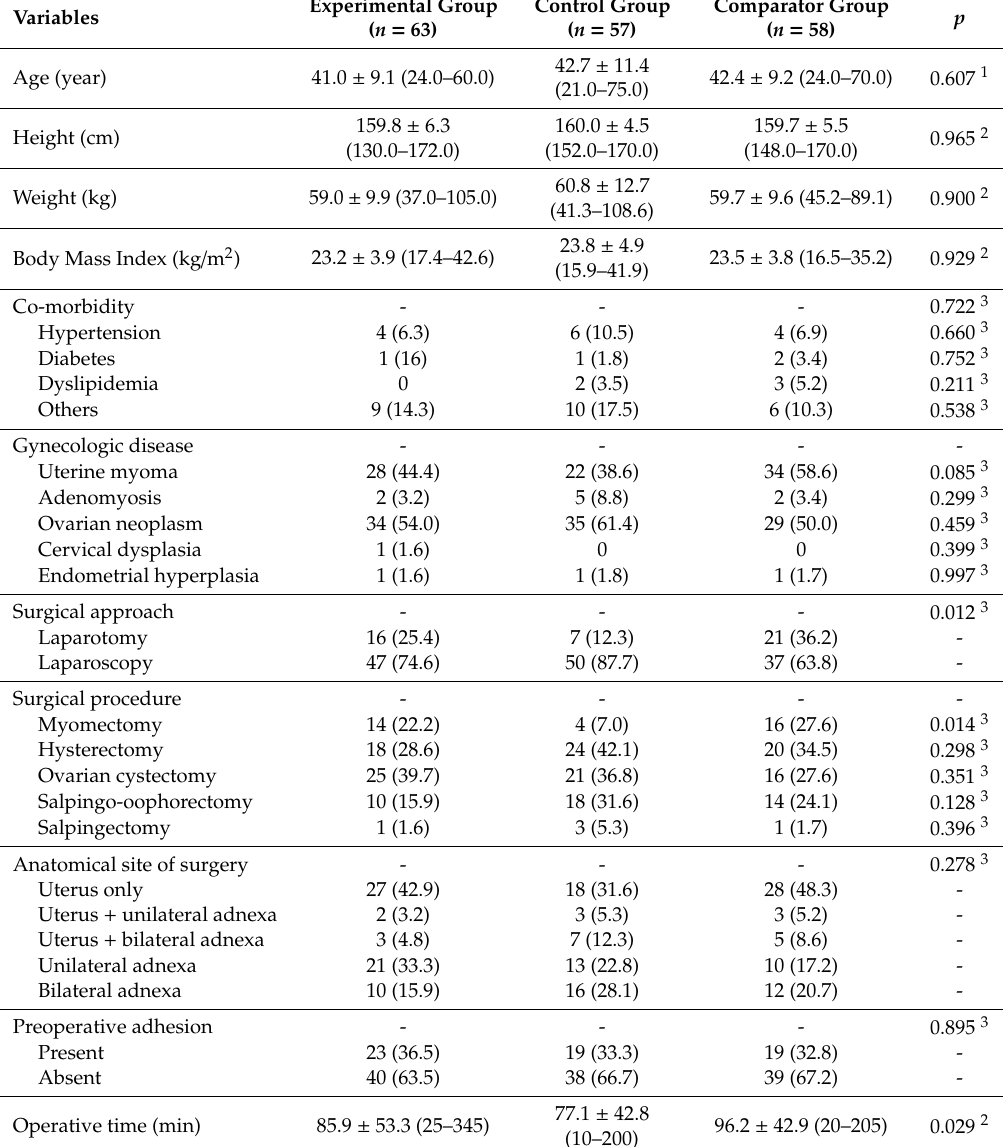
Table 1. Demographics and baseline characteristics of the patients in full analysis